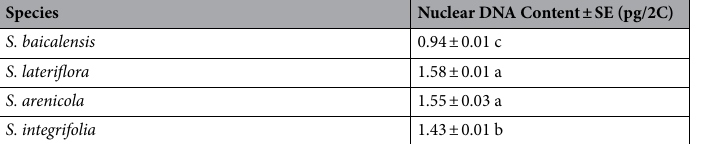
Table 1. Nuclear DNA content of Scutellaria species in this study. Data are presented as mean ± Standard error (SE). Means with different letters are significantly different (Tukey HSD test, p < 0.05).